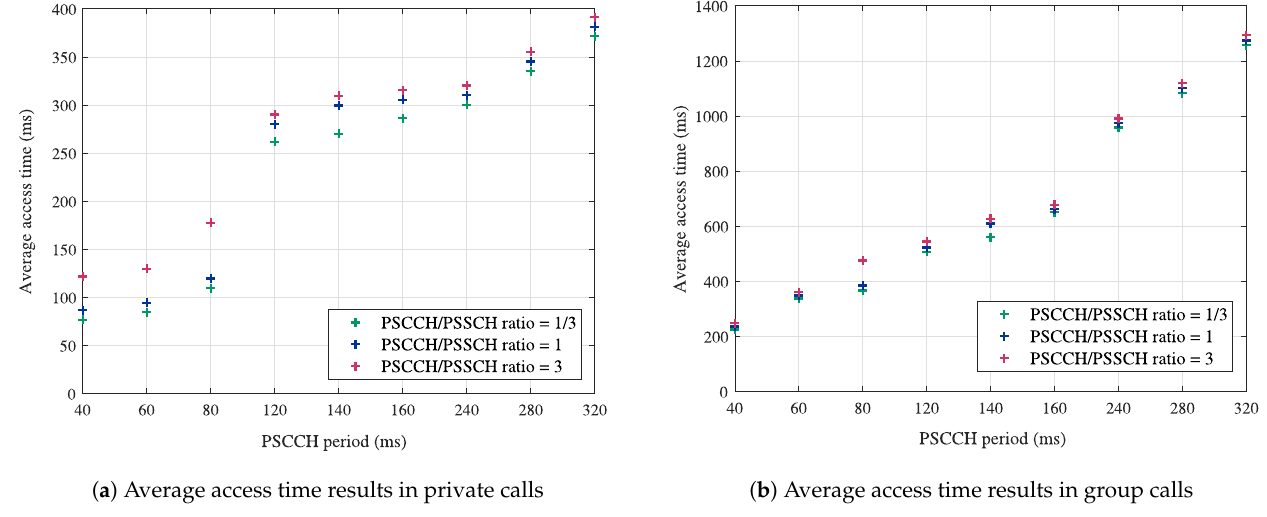
Figure 5. Impact of the PSCCH period and the PSCCH/PSSCH ratio on latency performance in MCPTT